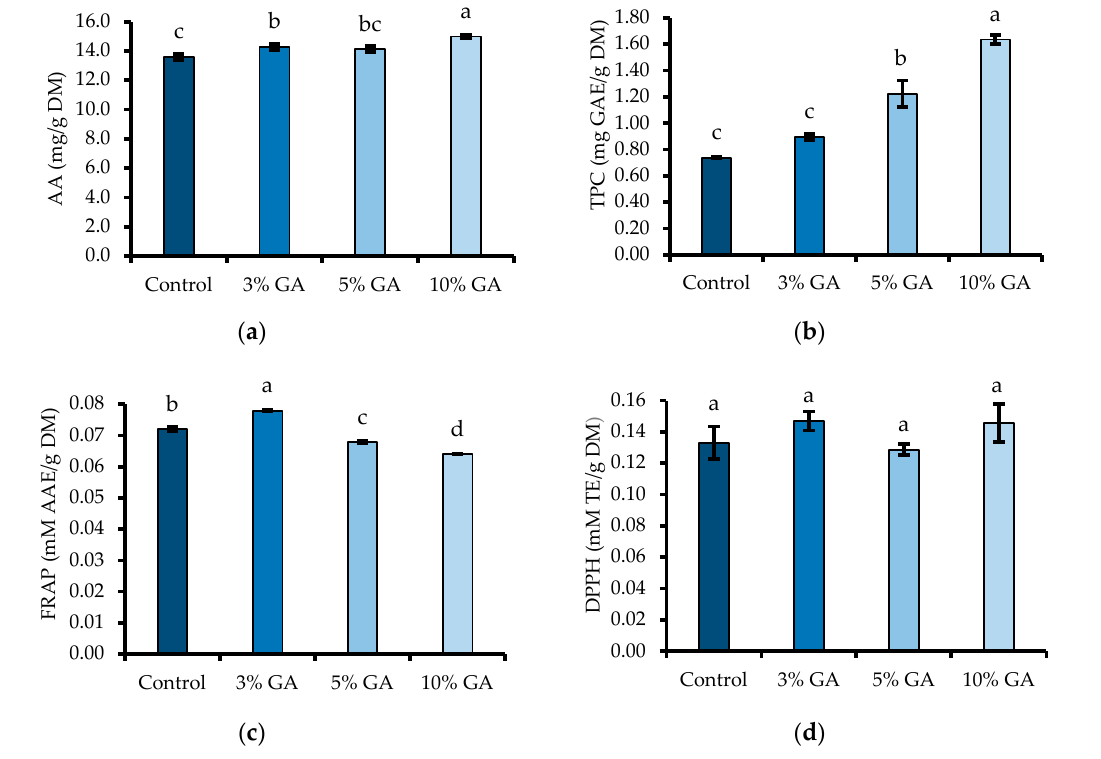
Figure 3. ( a ) Ascorbic acid (AA), ( b ) total phenolic content (TPC), ( c ) ferric-reducing antioxidant power (FRAP), and ( d ) DPPH radical scavenging capacity of the control, GA-pretreated and oven- dried (60 °C for 18–24 h) raspberries. Different letters on each bar indicate significant differences in the means ( p < 0.05), according to Duncan’s multiple range test. Vertical bars indicate the standard error of the mean. Control samples were dipped in distilled water for 2 min. GA = gum arabic; GAE = gallic acid equivalence; TE = trolox equivalence; and AAE = ascorbic acid equivalence.